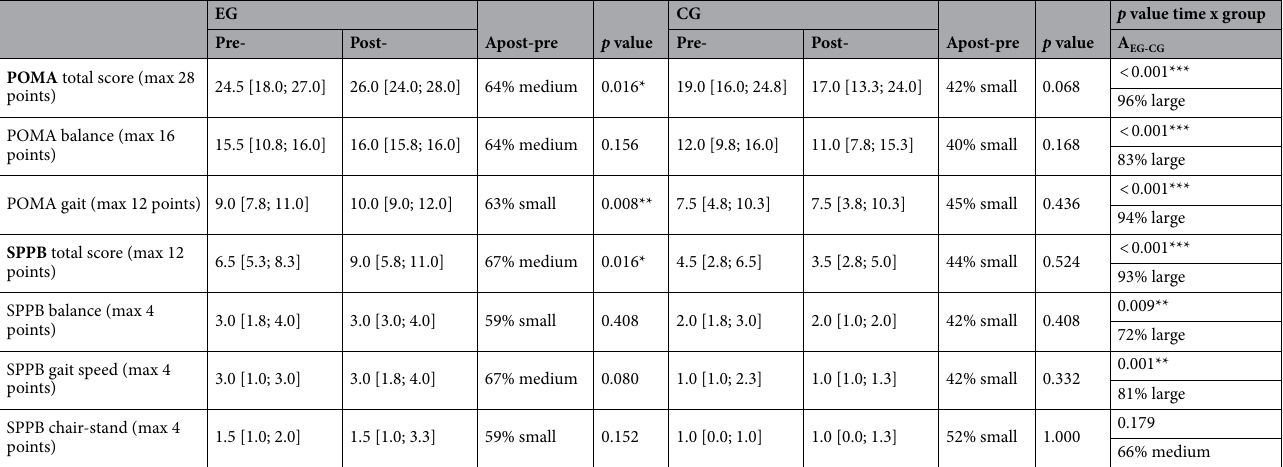
Table 3. Changes in functional performance evaluated throughout the performance-oriented mobility assessment (POMA) and short physical performance battery (SPPB). Data are the median [Q25; Q75]. AEG-CG stochastic superiority of the interaction of the time (post- vs. pre-) and the group (EG vs. CG), Apost-pre stochastic superiority of post- versus pre-, Pre- preintervention assessment, Post-